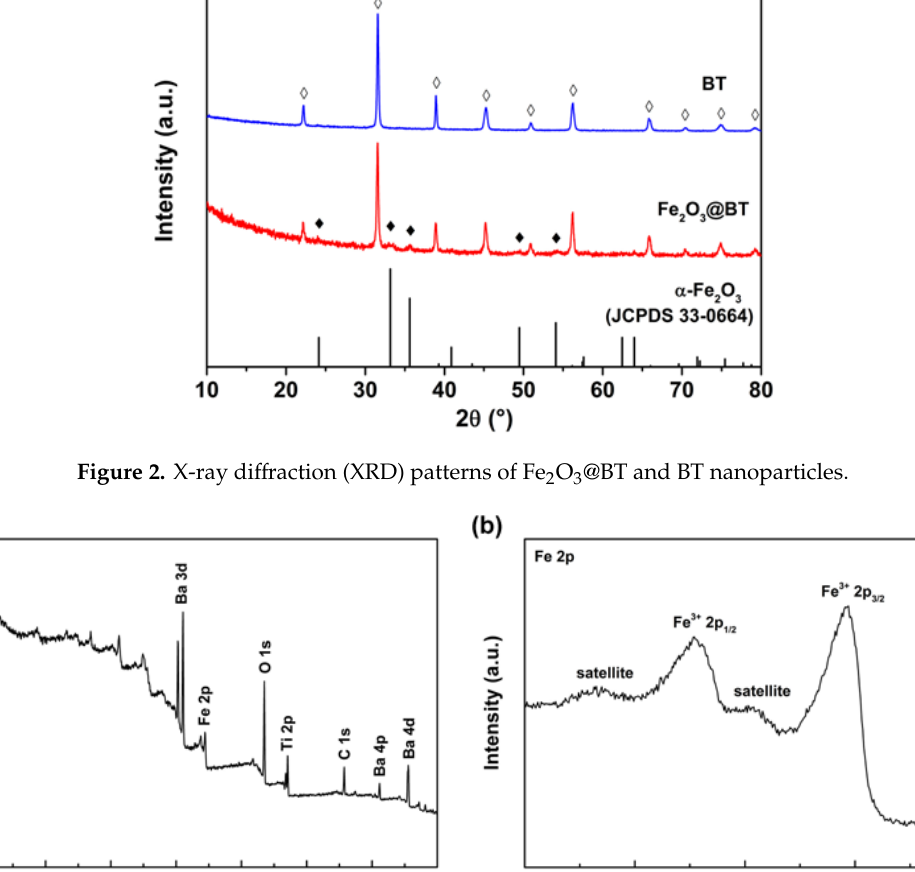
Figure 2. X-ray diffraction (XRD) patterns of Fe 2 O 3 @BT and BT nanoparticles.